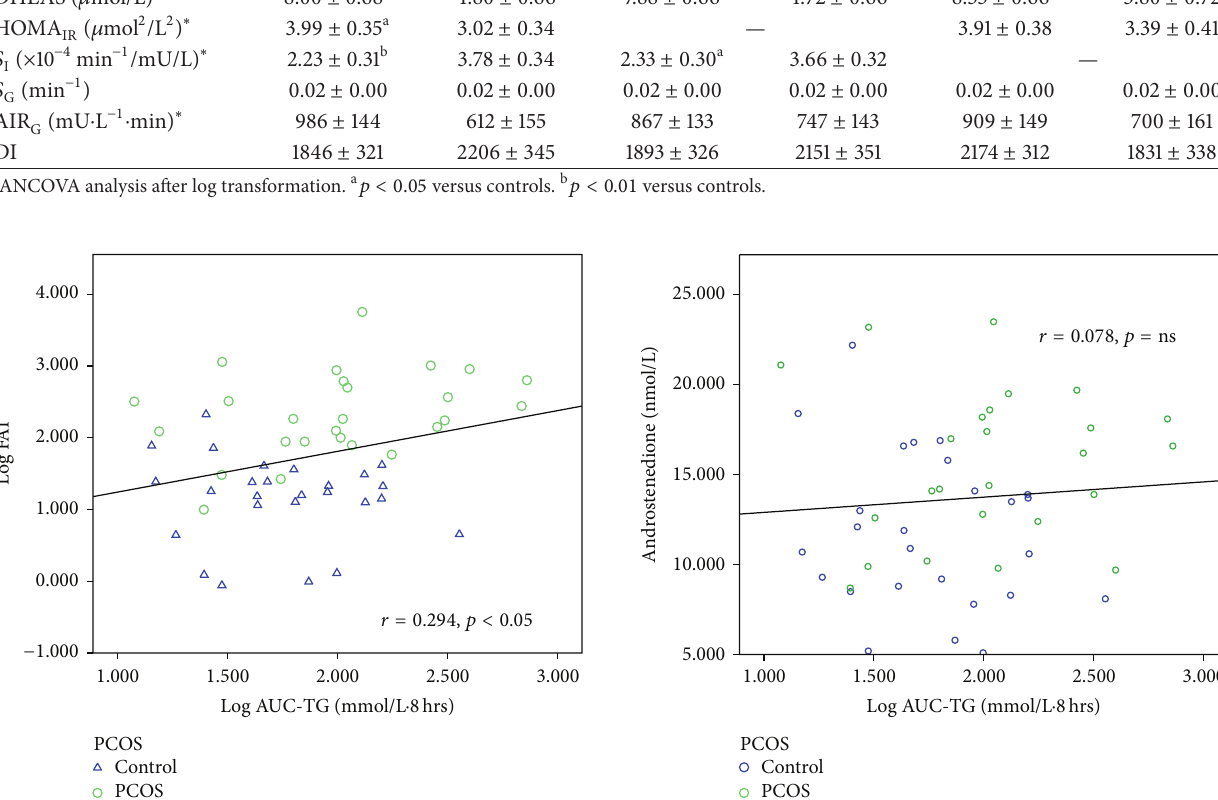
AUC-HDL correlated significantly positively with body water 0.454 ). AUC-HDL also correlated negatively with TG at all time points, iAUC-TG, iAUC-B48, apoA-I at 2, 4, and 6 hours and AUC-apoA-I, glucose at 0 and 2 hours, AUC-glucose, not shown). There was a nonsignificant negative correlation with androstenedione ( 𝑟 = −0.27 , 𝑝 = 0.055 ). AUC-TG and WC were the only independent predictors of